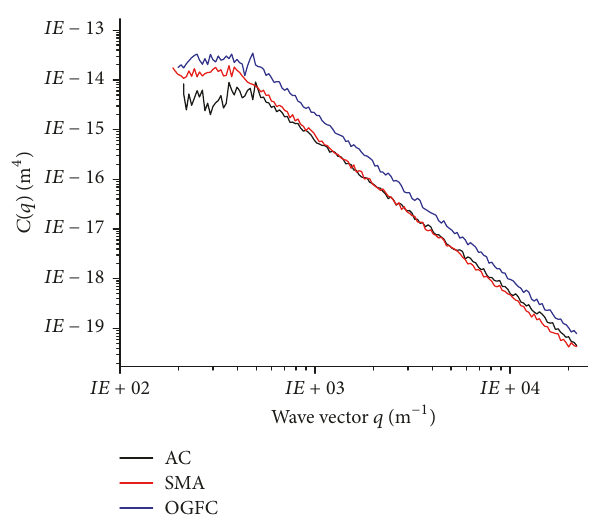
Figure 2: Surface power spectrum of asphalt